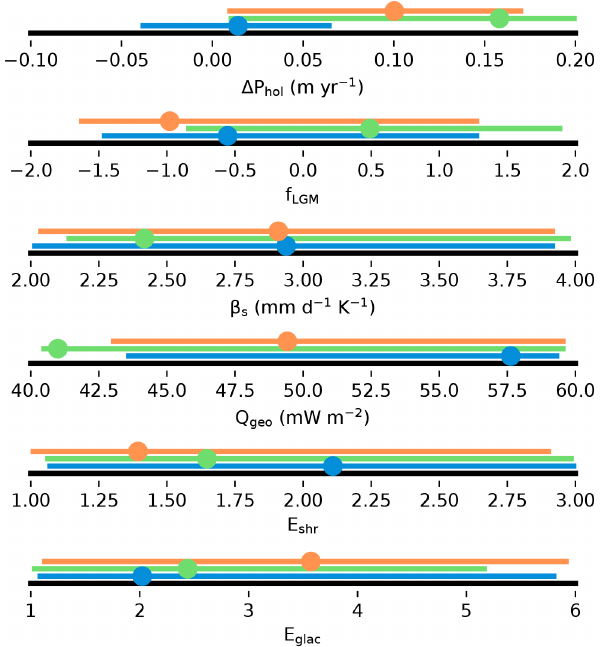
Figure 9. Parameter range for the top 10% of simulations for the ice thickness metric (green), the combined RMSE (blue), and the combined RMSE based on the Eulerian age tracer (orange). Simula- tions BEST ice , BEST all , and the corresponding optimal simulation for the Eulerian age tracer are highlighted with